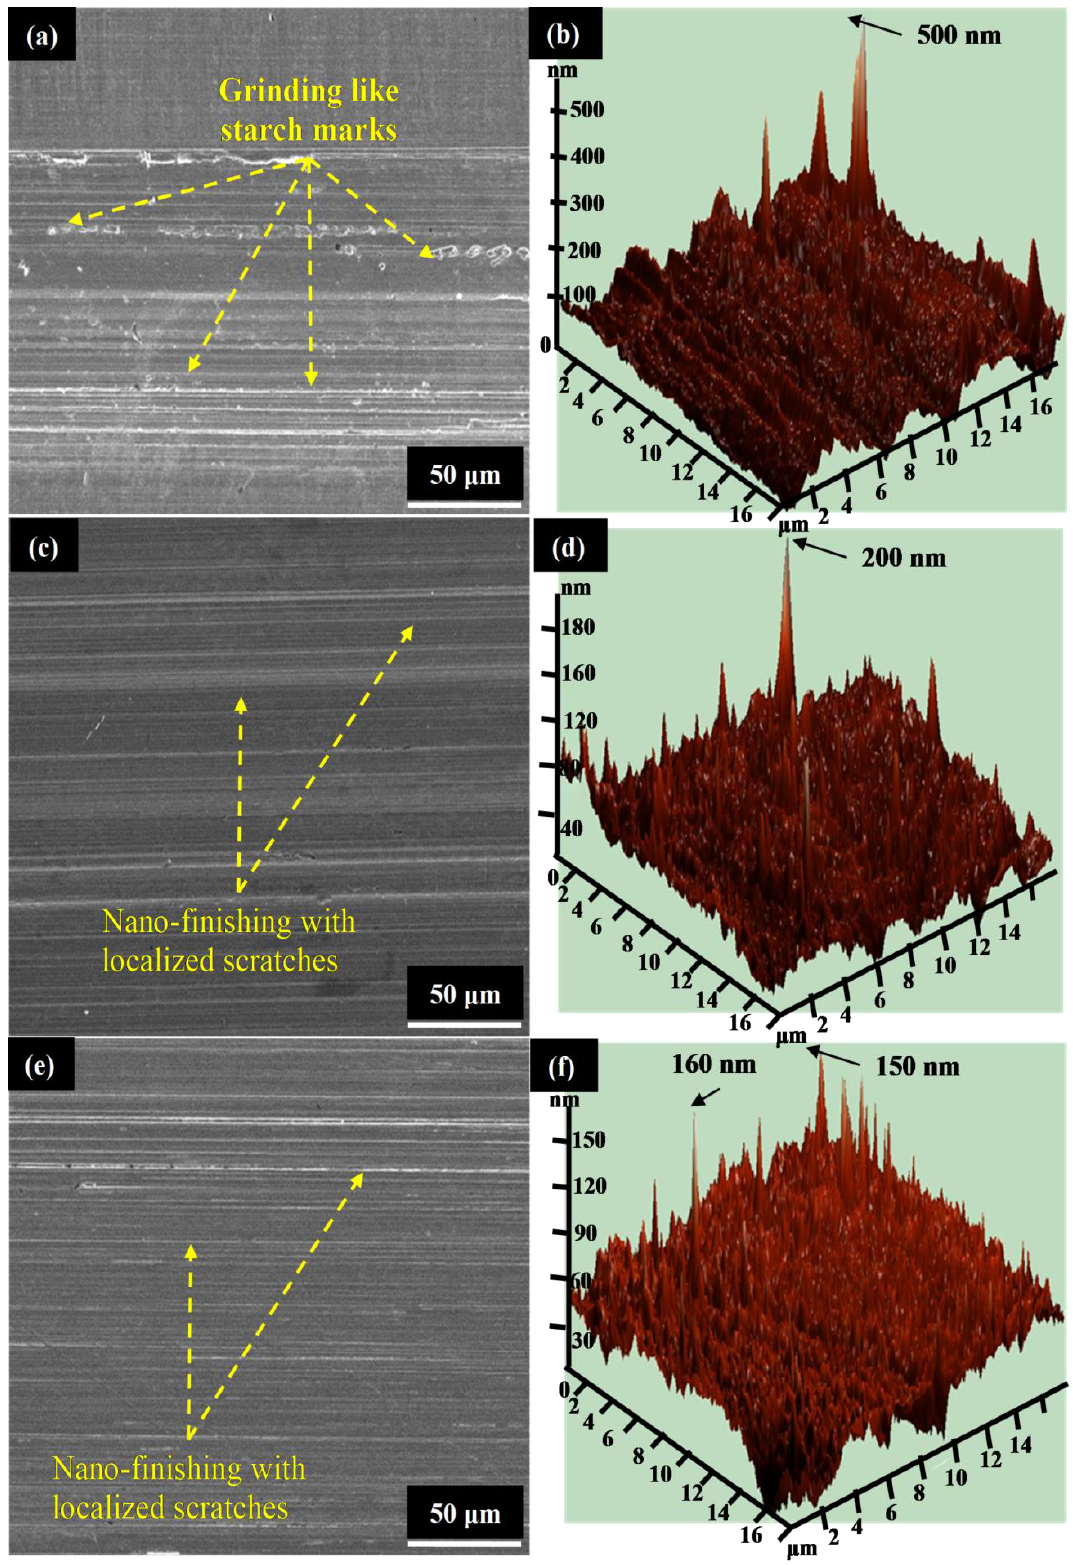
Figure 4. Surface morphology and AFM imaging of MRF-AF processed alloy surface ( a , b ) at 600 rpm, ( c , d ) at 1200 rpm, and ( e , f ) at 900 rpm.